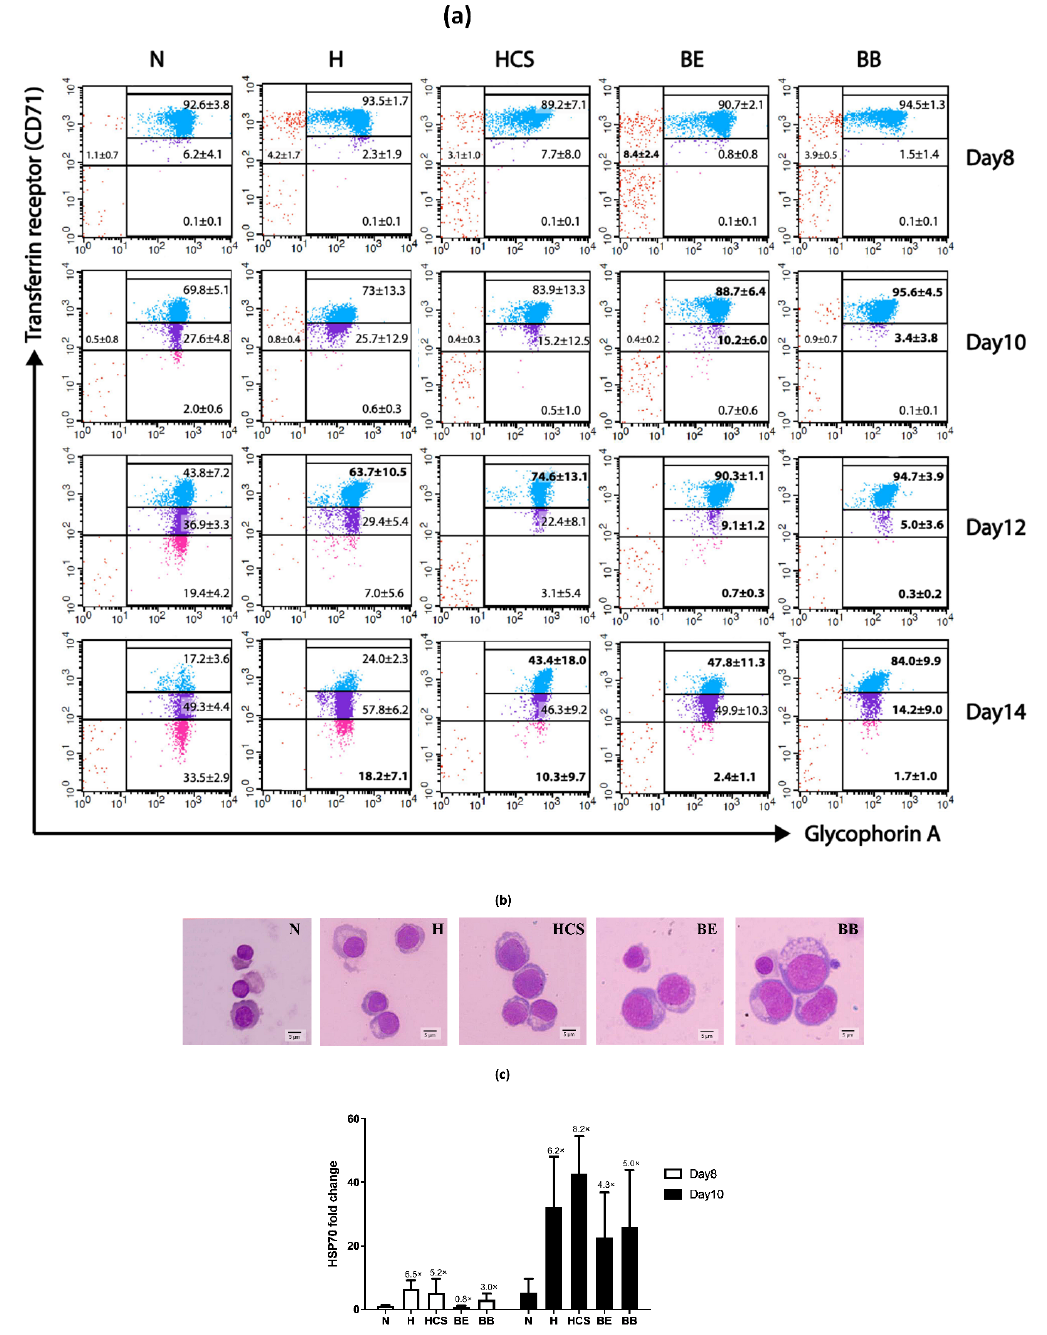
Figure 3. Delayed thalassemic erythroid cell differentiation during in vitro erythropoiesis. ( a ) Rep- resentative flow cytometry density dot plots of normal and thalassemic erythroid cells maturation during in vitro erythropoiesis. Red dots: CD71 high/GPA negative cells, blue dots: CD71 high/GPA positive cells, purple dots: CD71 moderate/GPA positive cells, pink dots: CD71 low/GPA positive cells. ( b ) Wright–Giemsa staining of cells harvested from day 14 culture. ( c ) Levels of HSP70 mRNA in erythroid cells days 8 and 10 of culture. Results from quantitative RT-PCR have been depicted from day 8 (white bar) and day 10 (black bar) of culture as relative fold change with the mean and SD value from independent subjects of each thalassemia group compared to the normal